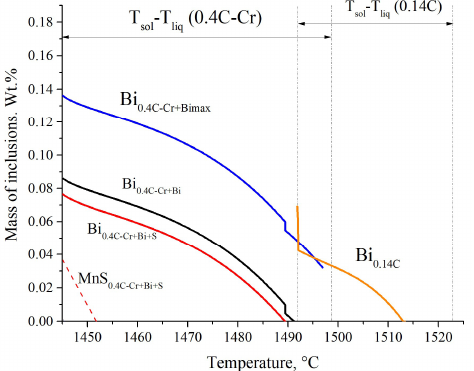
Figure 7. The dependence of the temperature of formation and the amount of formed particles of bismuth and manganese sulfide in experimental steels.